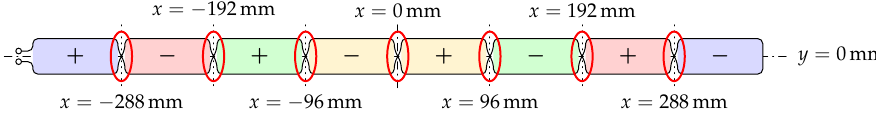
Figure 9. Positions where a foreign object can stimulate the sensor coil 6